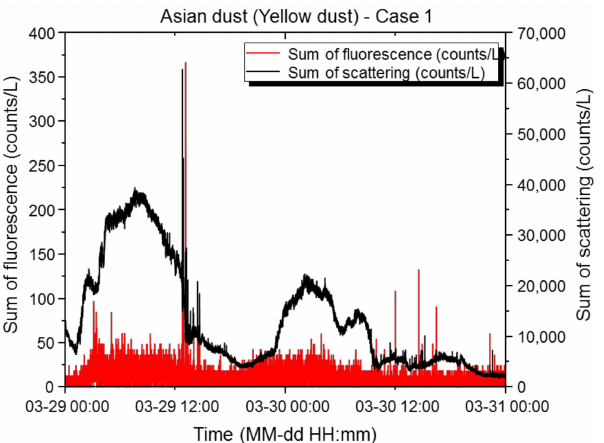
Figure 7. Results of light scattering and fluorescence measurements of the biological particle detector during Asian dust. Time-dependent concentrations of scattered light and fluorescent particles in Case 1. The X-axis represents the measurement period, and the Y-axis represents the measured particle concentrations. The black line represents the scattered light sum (counts/L), and the red line represents the fluorescence sum